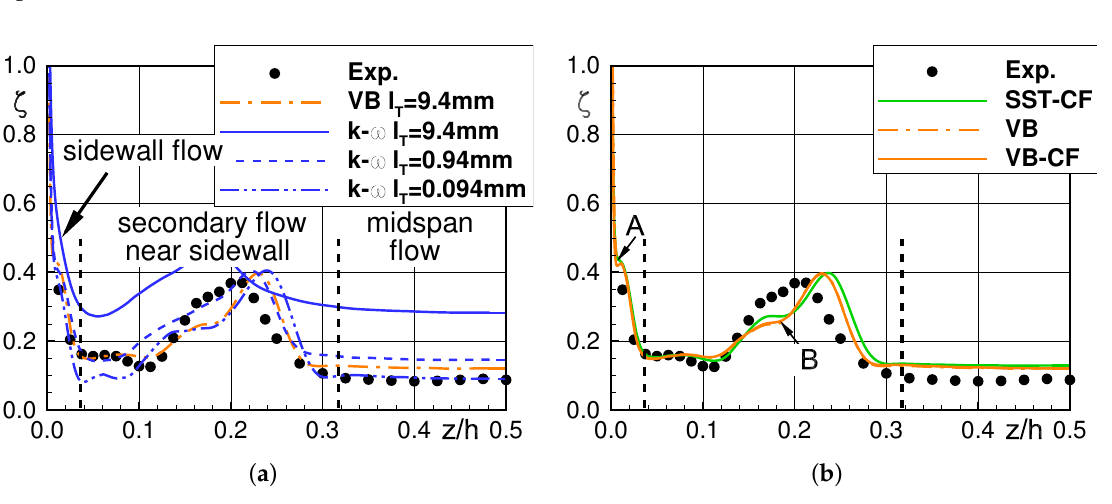
Figure 1. Pitchwise averaged spanwise distributions at slot 10 compared to Figure 5 in [7]. ( a ) Effect of turbulence length scale l T ; ( b ) Effect of crossflow extension (CF), l T =